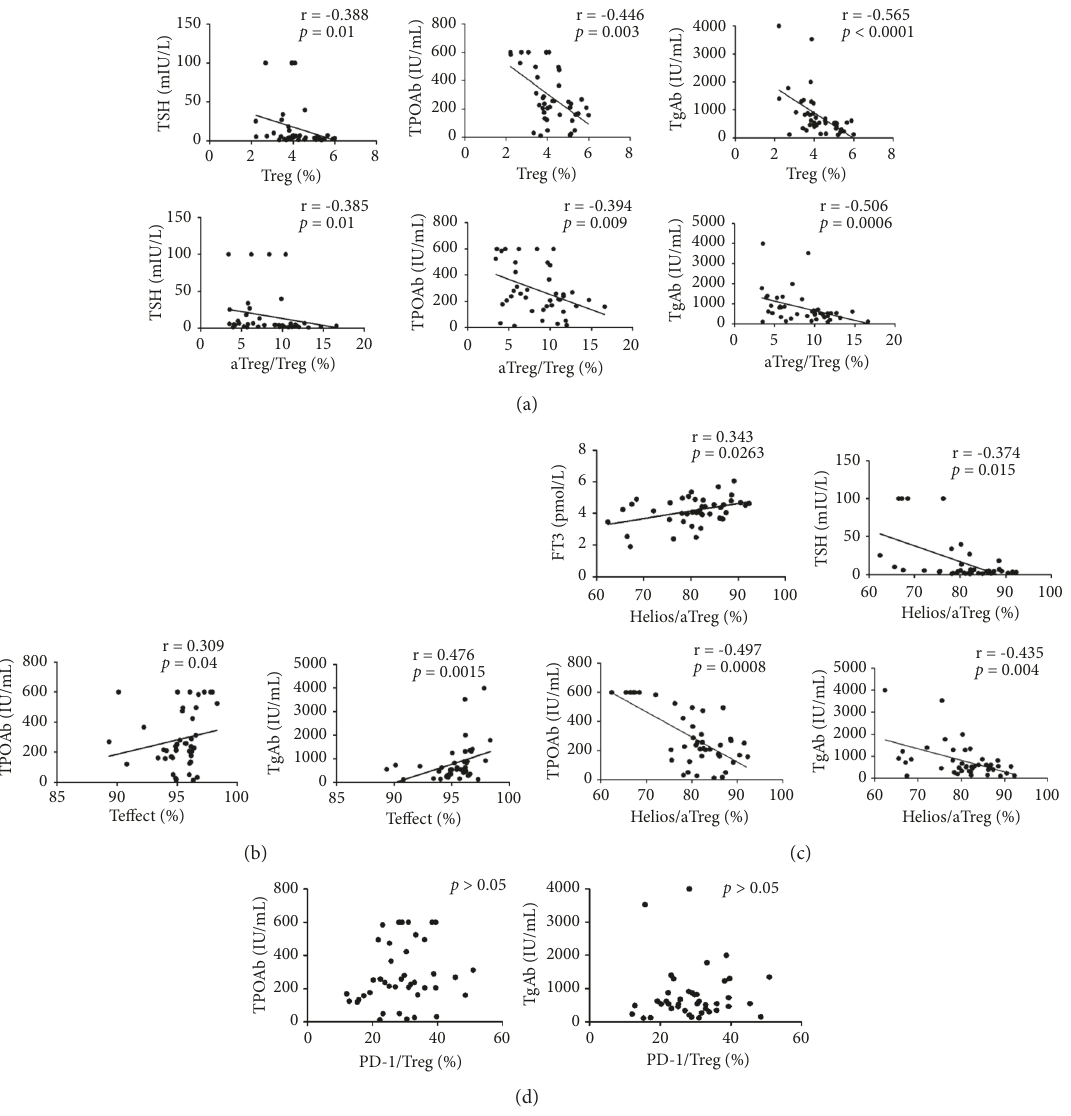
Figure 5: Spearman pairwise correlation analysis in HT patients between (a) the Treg or aTreg ratio and TSH, TPOAb or TgAb levels. (b) The Teffect ratio and TPOAb or TgAb levels. (c) The proportion of Helios in aTreg and FT3, TSH, TPOAb or TgAb levels. (d) Proportion of PD-1 in Treg and TPOAb or TgAb levels (r: Spearman correlation coefficient, significance P < 0.05).